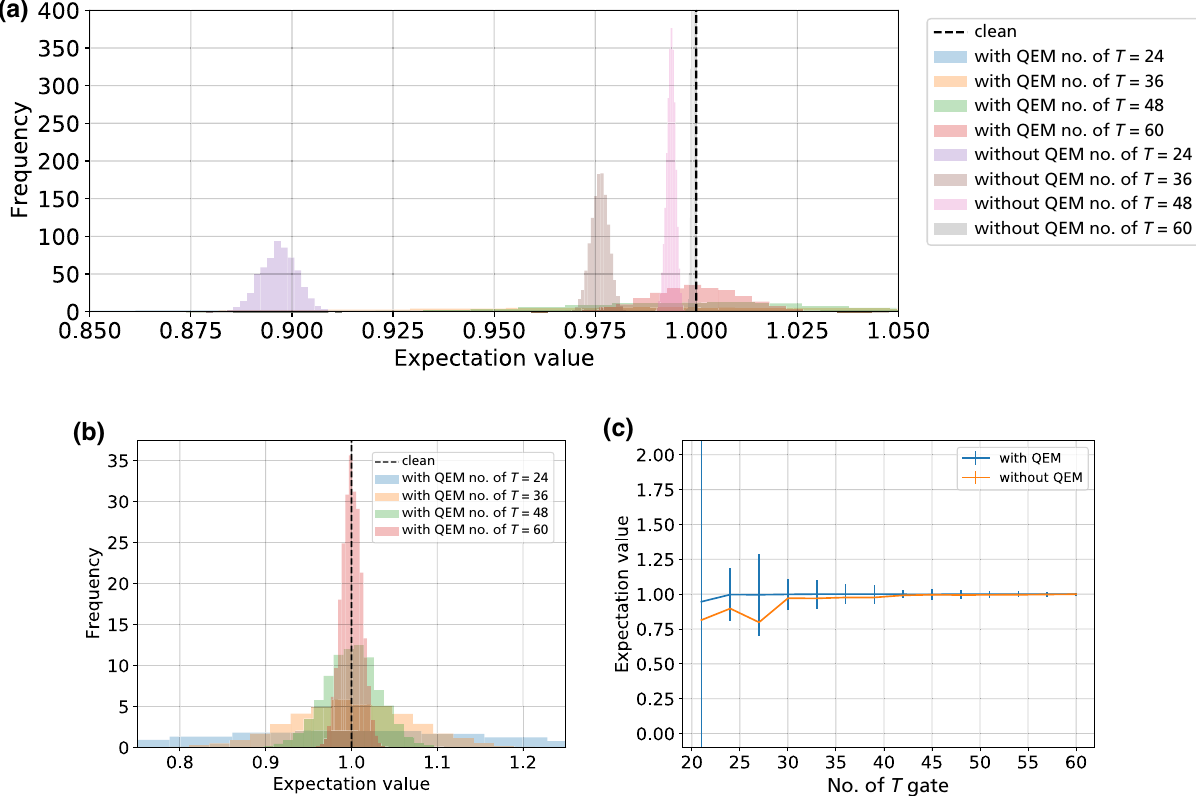
FIG. 8. Histogram of expectation values of SWAP test with approximation errors. (a) Histogram of expectation values. (b) The same figure enlarged around the ideal expectation value. (c) Sample averages and standard deviation as a function of the allowed number of T